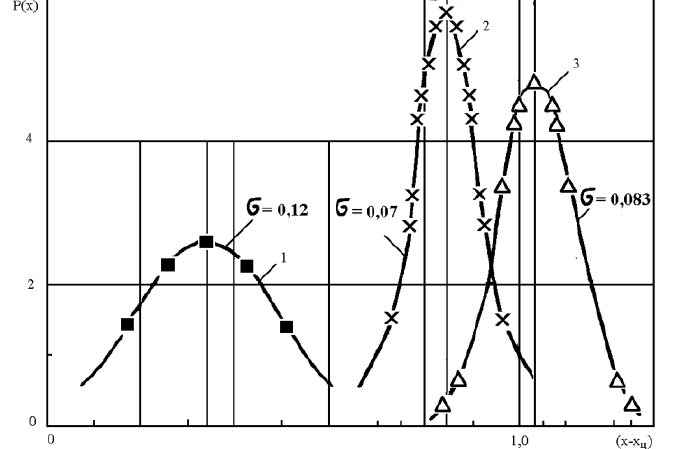
Fig. 3. Distribution of averaged U 0 OUT CMOS chip LSI RAM 1617 РУ 6 dose of (1), Uthr n-channel and p-channel MOS transistors (2, 3), obtained at an electron accelerator with E = 130